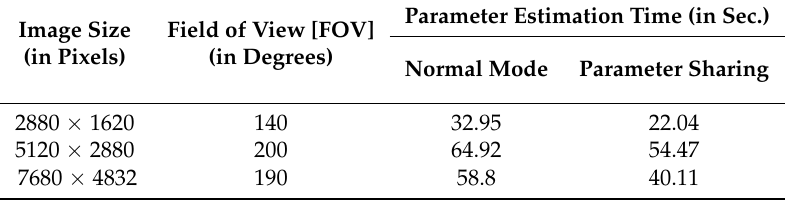
Table 2. Use case of parameter sharing scheme on high-resolution larger FOV image